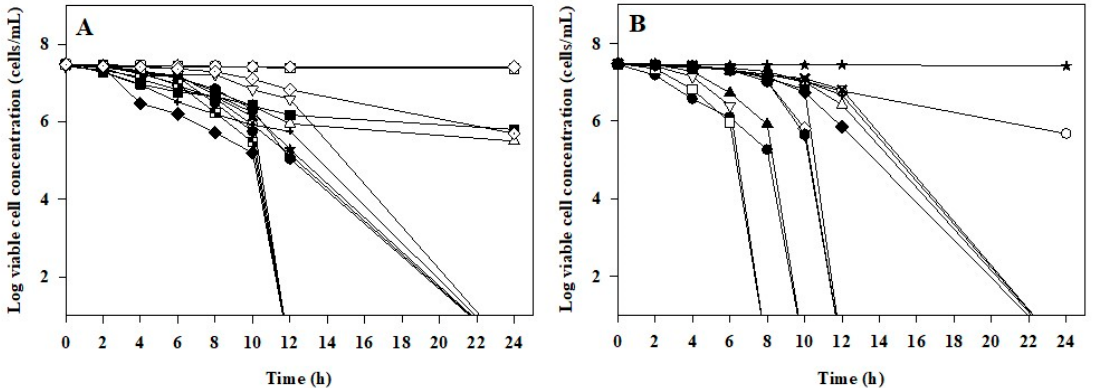
Figure 1. Time profiles of yeast isolates from sugar cane juice (SCJ), grapes (GR) and sweet sorghum juice (SSJ) grown on SSJ containing 100 g/L of total sugar and 15% ( v / v ) of ethanol; ( A ): SCJ01KKU( ), SCJ02KKU ( ), SCJ03KKU ( ), SCJ04KKU ( ), SCJ05KKU ( ), SCJ06KKU ( ), SCJ07KKU ( ), SCJ08KKU ( ), SCJ09KKU ( ), SCJ10KKU ( ), SCJ11KKU ( ), SCJ12KKU ( ), SCJ13KKU ( ) and SCJ14KKU ( ); ( B ): GR01KKU ( ), GR02KKU ( ), GR03KKU ( ), GR04KKU ( ), GR05KKU ( ), GR06KKU ( ), GR07KKU ( ), GR08KKU ( ), GR09KKU ( ), GR10KKU ( ) and SSJ01KKU ( ) , NP01 ( ) and ATCC4132 ( ) .